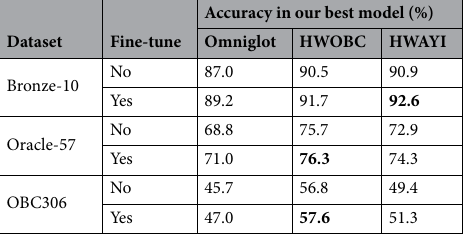
Table 6. Exploring the generalization ability of the model and transfer to other ancient character datasets for recognition accuracy. Significant values are in bold.